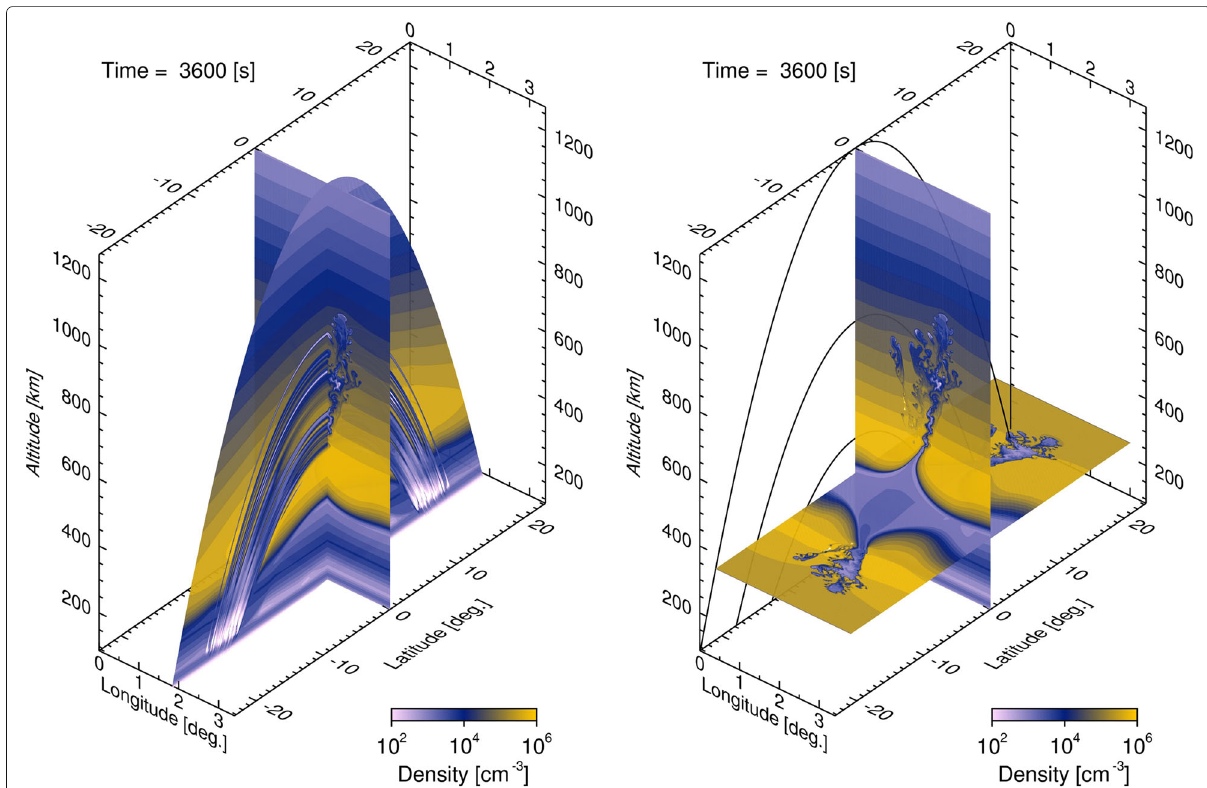
Fig. 7 3D view of HIRB model results. Reproduced from Yokoyama et al. (2014)